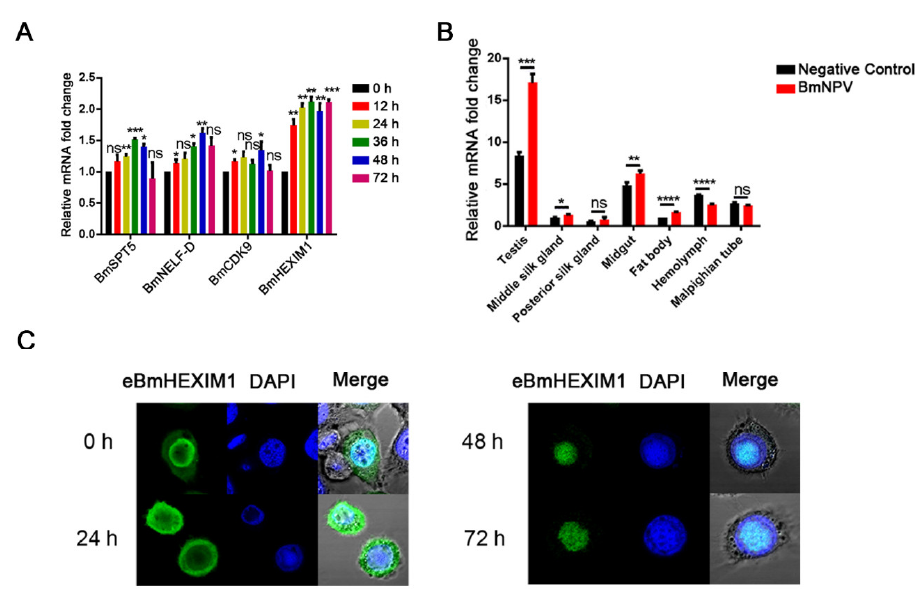
Figure 1. BmHEXIM1 showed a significant response to BmNPV infection. ( A ) The expression levels of BmHEXIM1 in BmN cells at different hours post infection with BmNPV. BmN cells without BmNPV infection as the control. ( B ) The expression levels of BmHEXIM1 in different tissues of silkworm post infection with BmNPV. Fat body of silkworm without BmNPV infection as the control. ( C ) Time course analysis of subcellular localization of BmHEXIM1 by immunofluorescence in BmN cells infected by BmNPV; DAPI, blue; and BmHEXIM1, green. The mRNA level of target genes was normalized to the internal control (BmRPL32). Data represent mean ± SEM of the three independent experiments. The number of asterisks represents the degree of significance with respect to p -value. P -values were provided as * p < 0.05; ** p < 0.01; *** p < 0.001; **** p < 0.0001. The coding sequence of BmHEXIM1 is 996 bp and encodes 332 amino acids. Moreo- ver, a query of the NCBI database showed that BmHEXIM1 was located on chromosome 25 of the silkworm. By BLASTP analysis, the E-value and identity HEXIM1 sequence of Bombyx mori (accession XP_004921854.1) were found to be significantly different com- pared with HEXIM1 from Drosophila melanogaster (accession NP_650381.1 and